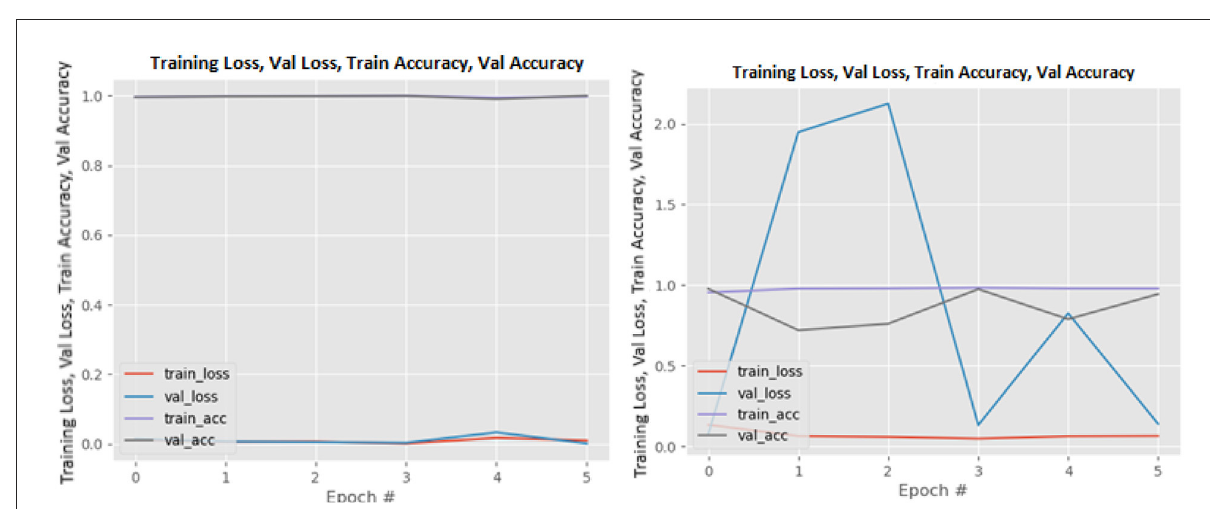
FIGURE16 ResNet101V2 without data augmentation (left image) and with data augmentation (right